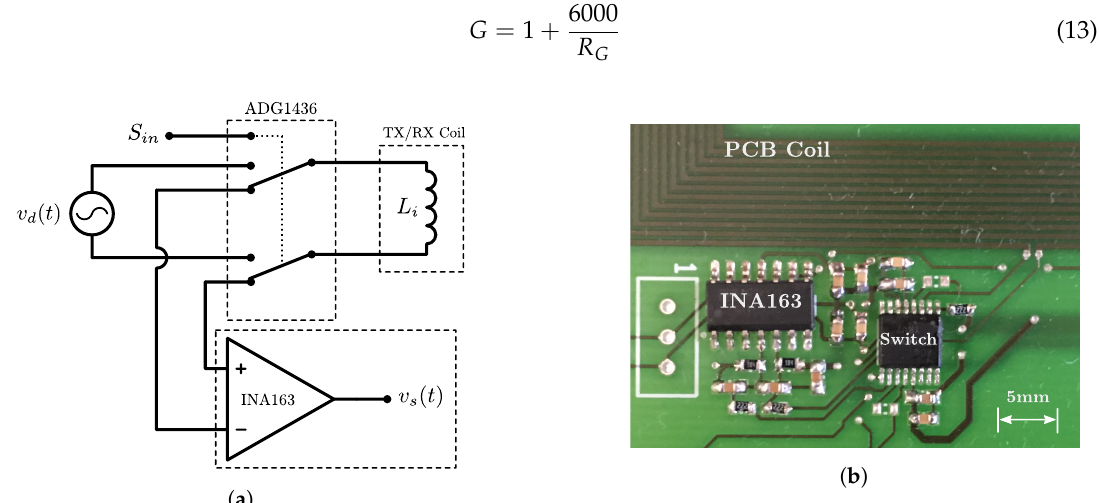
Figure 7. ( a ) Simplified circuit diagram of the coil switching circuit. The ADG1436 behaves as a double-pole double throw (DPDT) switch enabling the coil to switch between TX and RX modes. S in is the logic signal used to control the switch position. In TX mode, the switch connects the driving source v d ( t ) to the coil to produce a stable time-varying magnetic field. In RX mode the INA163 is connected to the coil and is used to amplify the induced voltage signal to produce v s ( t ) . ( b ) Layout of the switching circuit on the PCB. Table 1. Properties of EMT transmitter